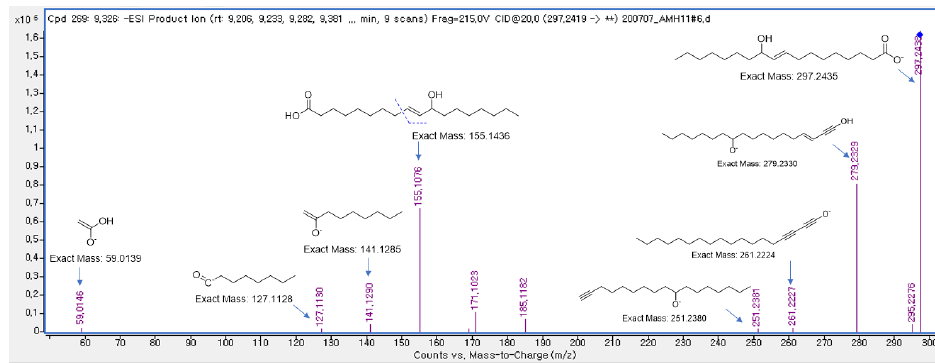
Figure 1. Chemical structure of compounds 1–10 .